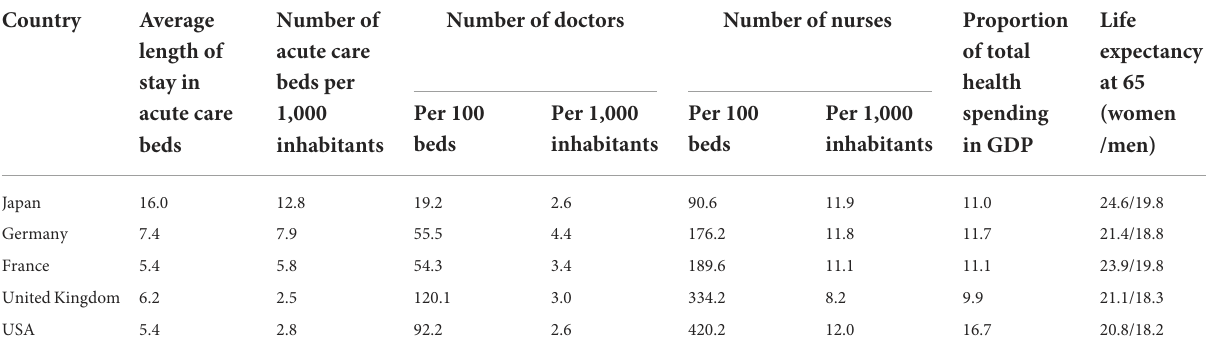
TABLE 6 Summary of the relationships between value variables and outcomes. Value